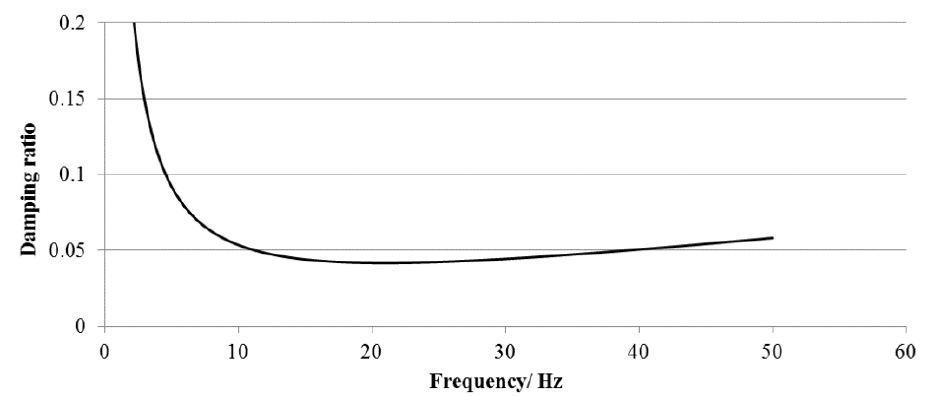
Figure 10. Distribution of damping ratio of the rock mass in frequency domain. Table 3. Physical and mechanical parameters of various materials.